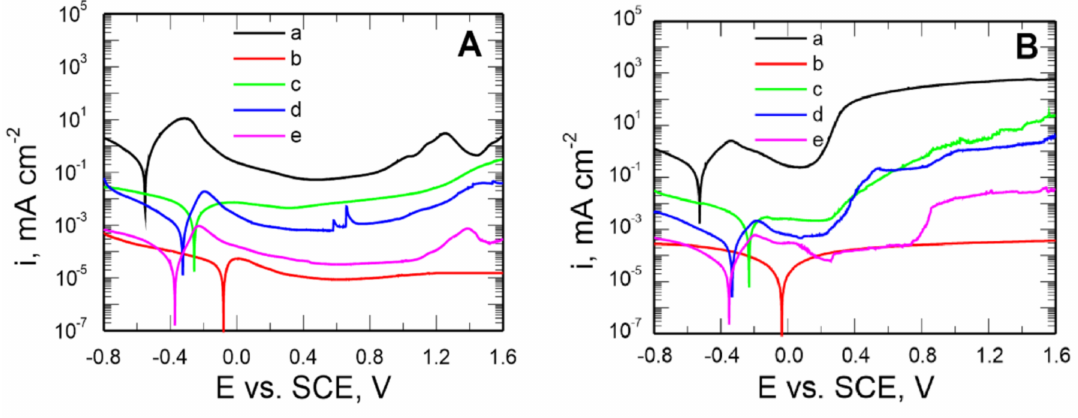
Figure 7. Potentiodynamic polarization curves recorded in the solution: 0.5 mol dm − 3 Na 2 SO 4 pH = 2 ( A ) and 0.5 mol dm − 3 Na 2 SO 4 + 0.5 mol dm − 3 NaCl pH = 2 ( B ) for uncoated steel X20Cr13 (a) and covered with coatings VTMS concentrations in a 3.16 mol dm − 3 solution and the addition of an electrolyte: CH 3 COOH (b), LiClO 4 (c), H 2 SO 4 (d), NH 3 (e). Polarization rate 10 mVs − 1 , solutions in contact with